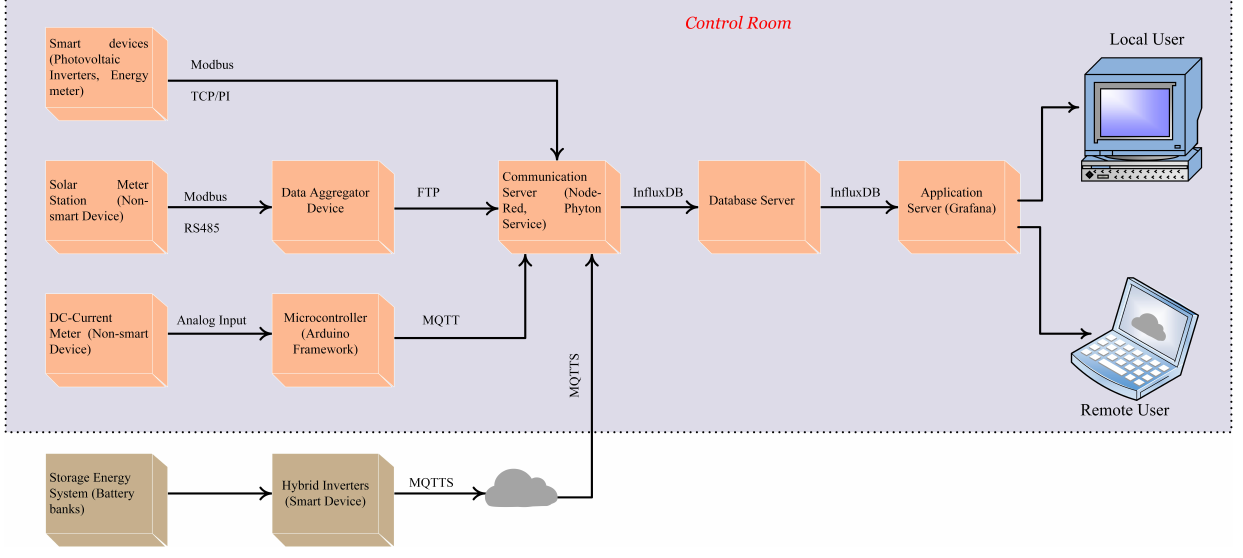
Figure 10. Schematic of the architecture of the data acquisition and data monitoring system, showcas- ing the communication protocols.